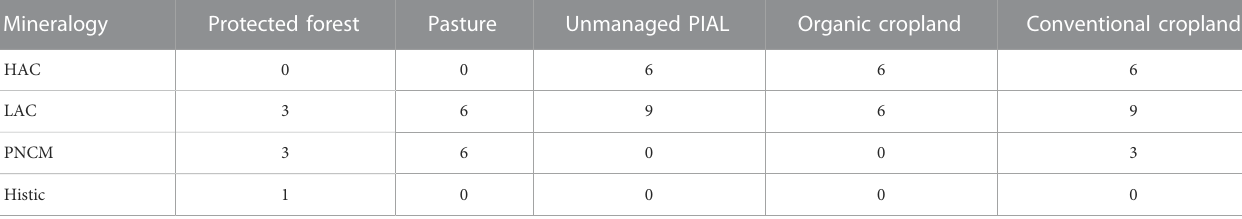
TABLE 2 Summary of sample numbers for each mineralogy class and current land use.